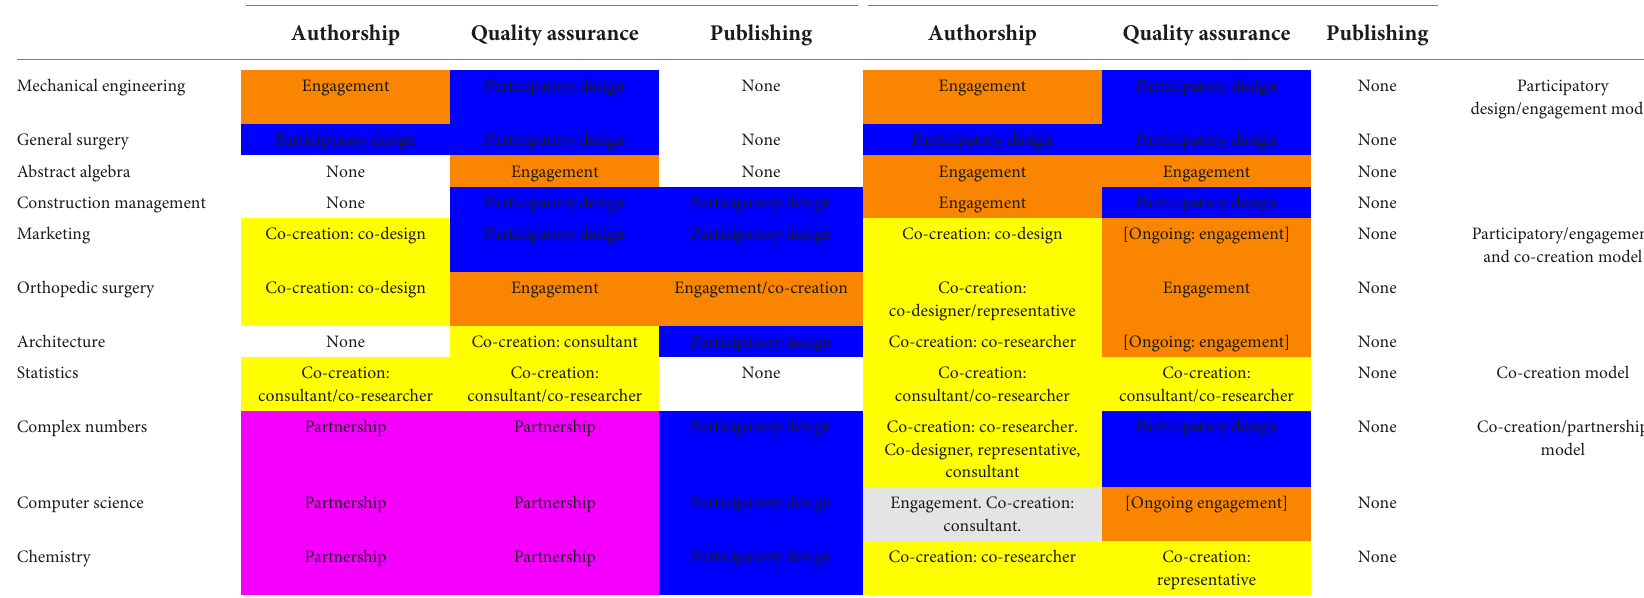
TABLE 3 Heat map ranking initiatives in terms of degree of social justice remedy (least to most, colleague versus student). Terms of inclusion: